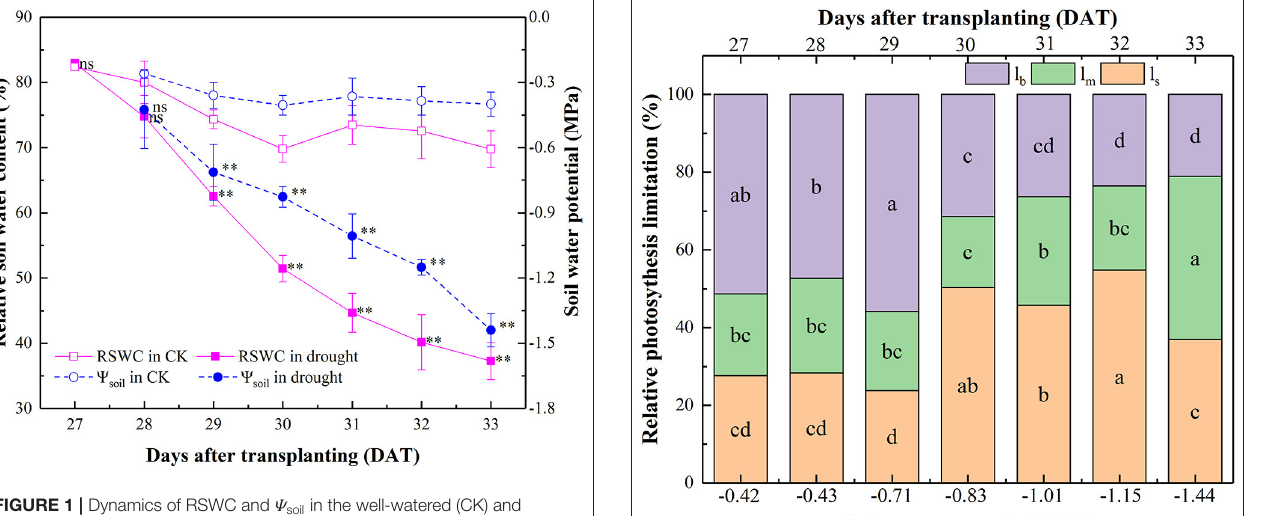
FIGURE 1 | Dynamics of RSWC and Ψ soil in the well-watered (CK) and drought-stressed tomato seedlings during 27–33 DAT. Mean values and SD were presented ( n = 6). ns indicated no significant difference and ** indicated significant difference at P < 0.01 level between drought and well-watered treatment.